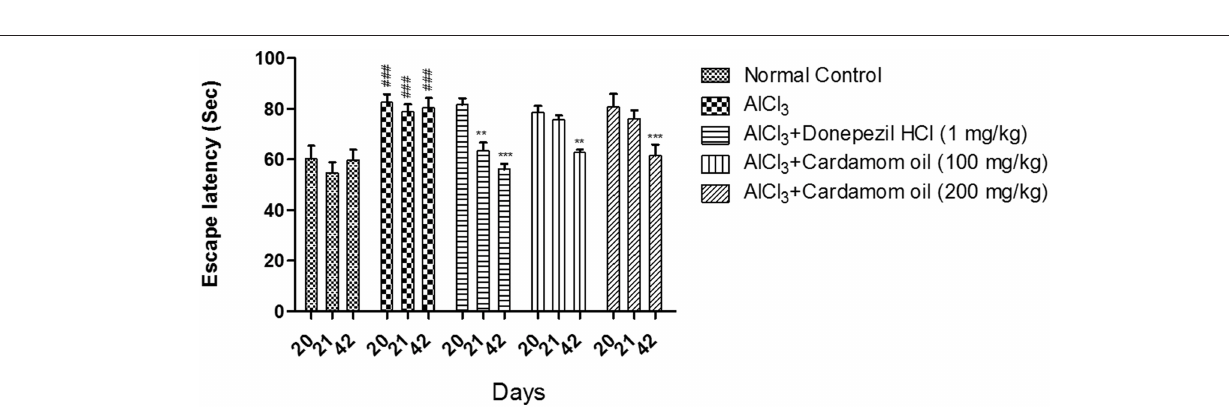
Frontiers in Neurology |